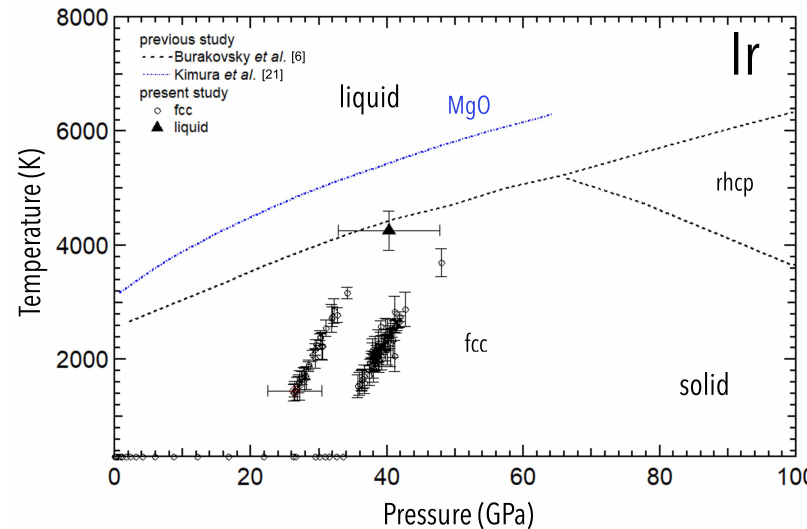
Figure 7. Ir phases as observed at the present experimental P – T conditions (solid symbols) compared to the DFT predicted phase diagram of Ir [6]. The melting line of MgO by Kimura et al. [21] is also reported for comparison. Errors in the T measurement are reported for all the experimental point obtained during laser heating. For simplicity, only the minimum and the maximum errors in P are reported for clarity reasons.